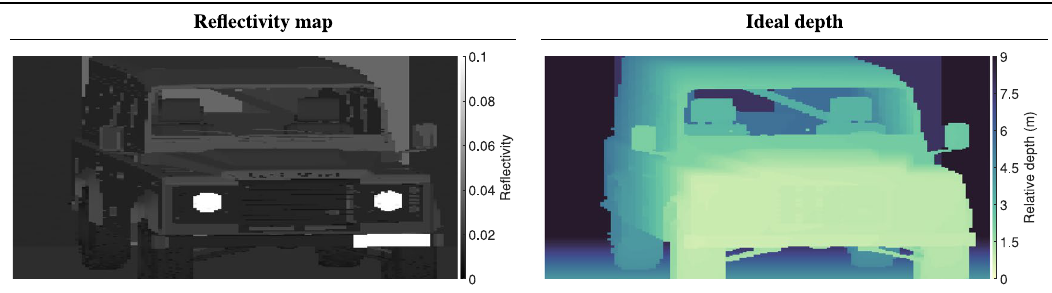
Figure 7. The reflectivity map (left) and ground truth depth map (right) created by the Unreal Engines’ virtual environment. The reflectivity map accounts for both the reflectivity coefficient of the surface as well as its orientation relative to the camera (the surface normal). Note that the colorbar of the reflectivity map has been clamped to aid in